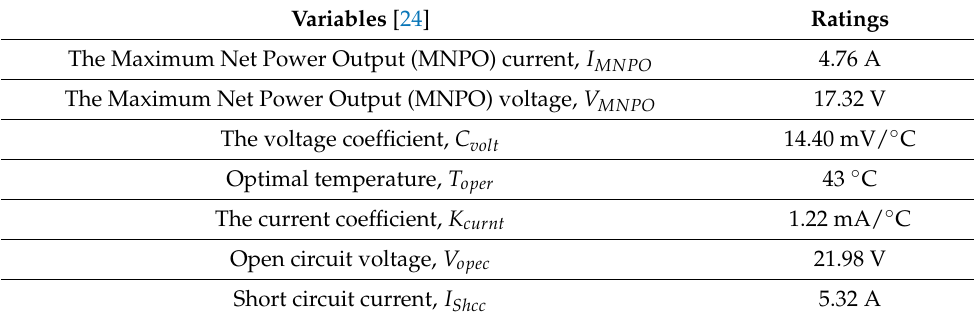
Table 1. Parameters of PV.